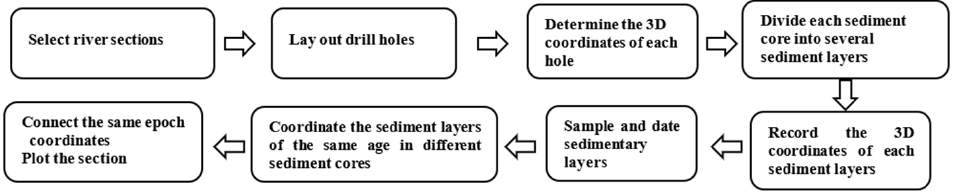
Figure 4. Conceptual flow chart of historical morphological cross-section recovery in the Lancang River.